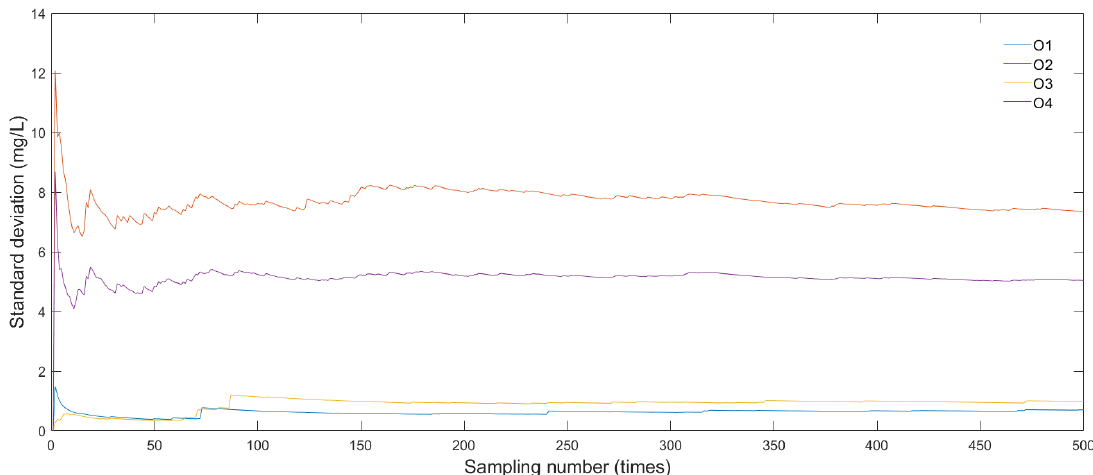
Figure 8. Iterative curves of standard deviation for O1–O4.